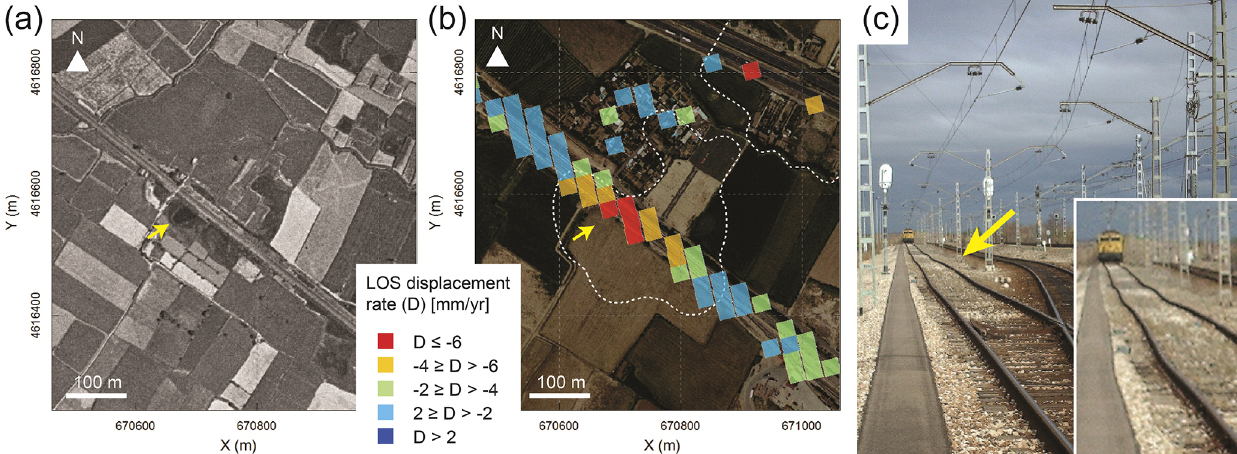
Figure 3. Section of the Castejón–Zaragoza railway built on a buried sinkhole and affected by active karst subsidence. (a) Aerial photograph taken in 1956. Arrow points to a ponded sector within the large subsidence depression. (b) Orthoimage from 2009 with ALOS-derived displacement rates on PSs. Dotted white line defines the boundaries of known active sinkholes. (c) Photographs of the location indicated with arrows in (a) and (b) , showing obvious deformation in the